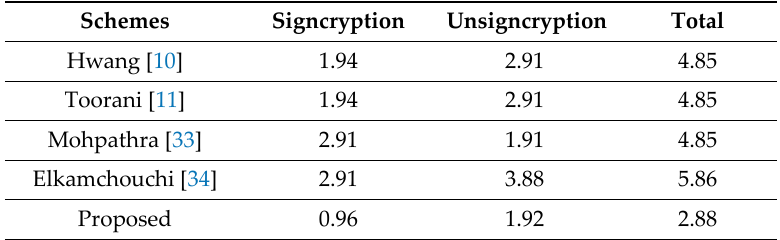
Table 3. Comparative computational cost in term of milli seconds